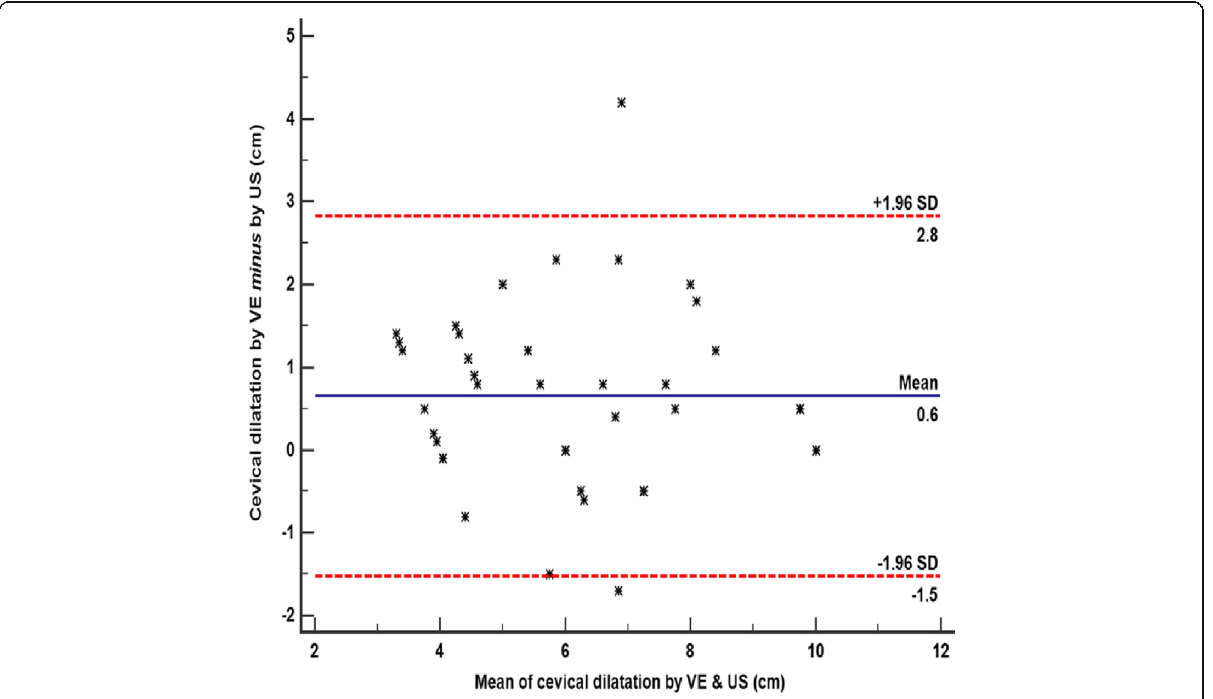
Fig. 11 Bland-Altman plot for agreement between VE and US as regards the assessment of cervical dilatation